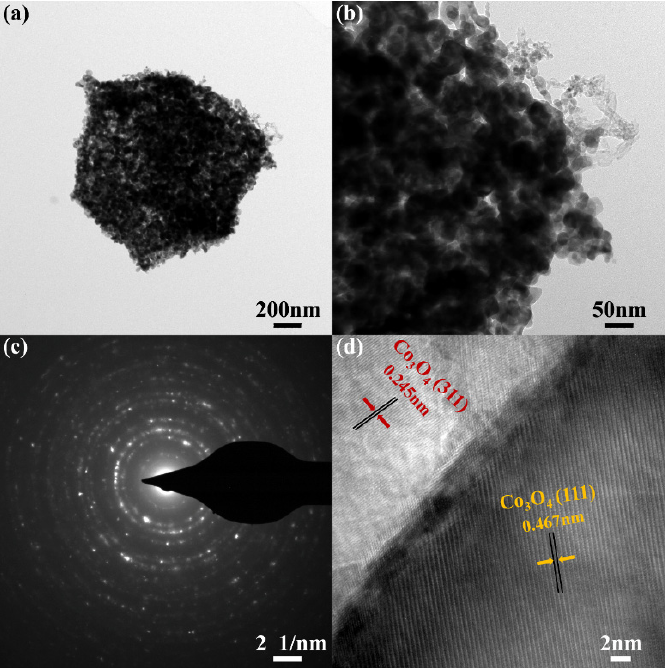
Figure 4. TEM images of C-MOF ( a , b ), SAED pattern of C-MOF ( c ), HRTEM image of C-MOF ( d ).